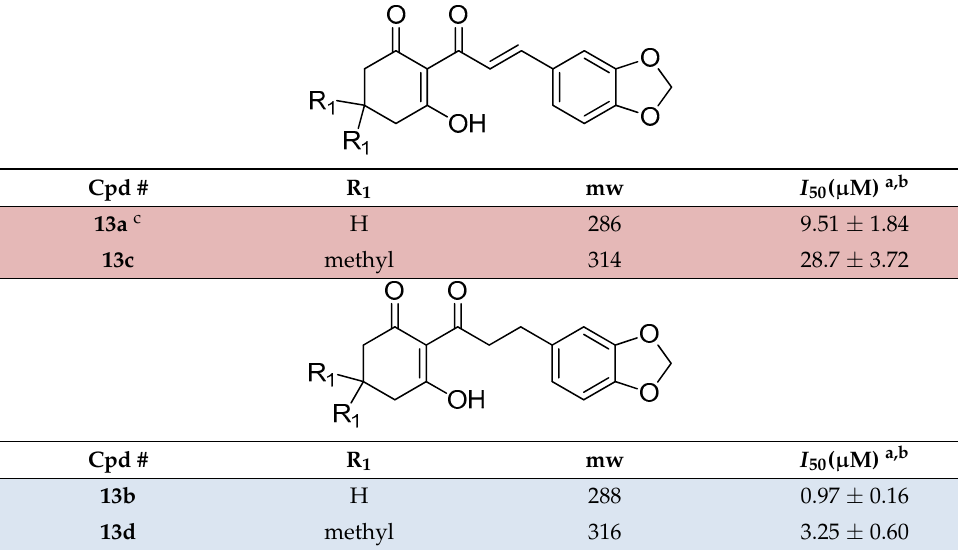
Table 5. Structures and activities of non-diones with simple aliphatic side chains tested in this